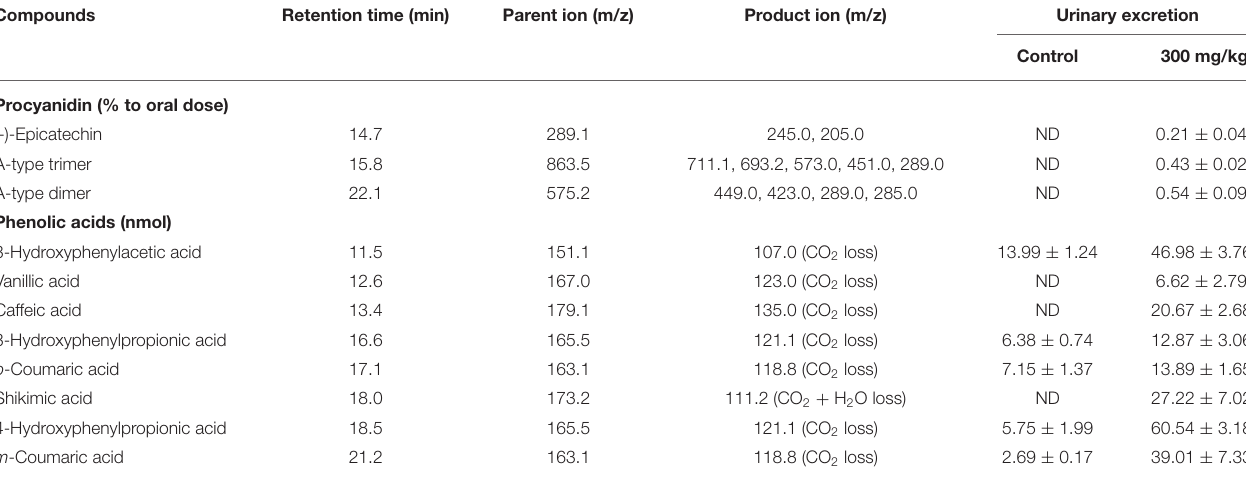
Control 300 mg/kg